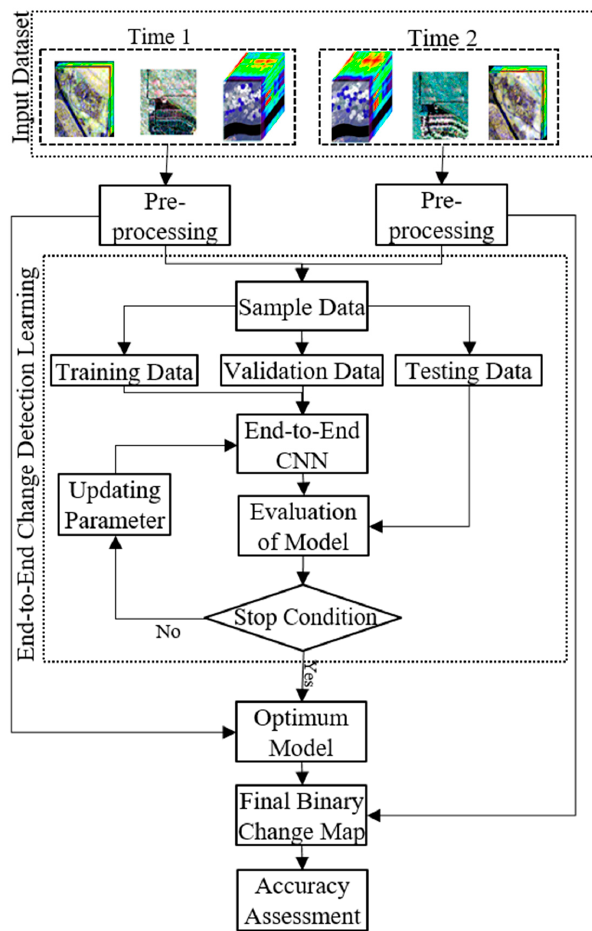
Figure 4. General flowchart of the proposed supervised binary change detection (CD) method.